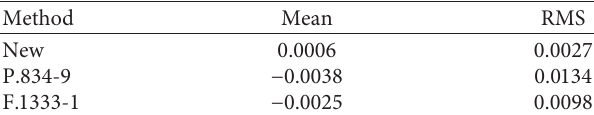
Figure 4: A schematic representation of the free-space propagation correction. Table 1: Errors for geosynchronous orbit satellites when the ap- parent elevation angle is known (in